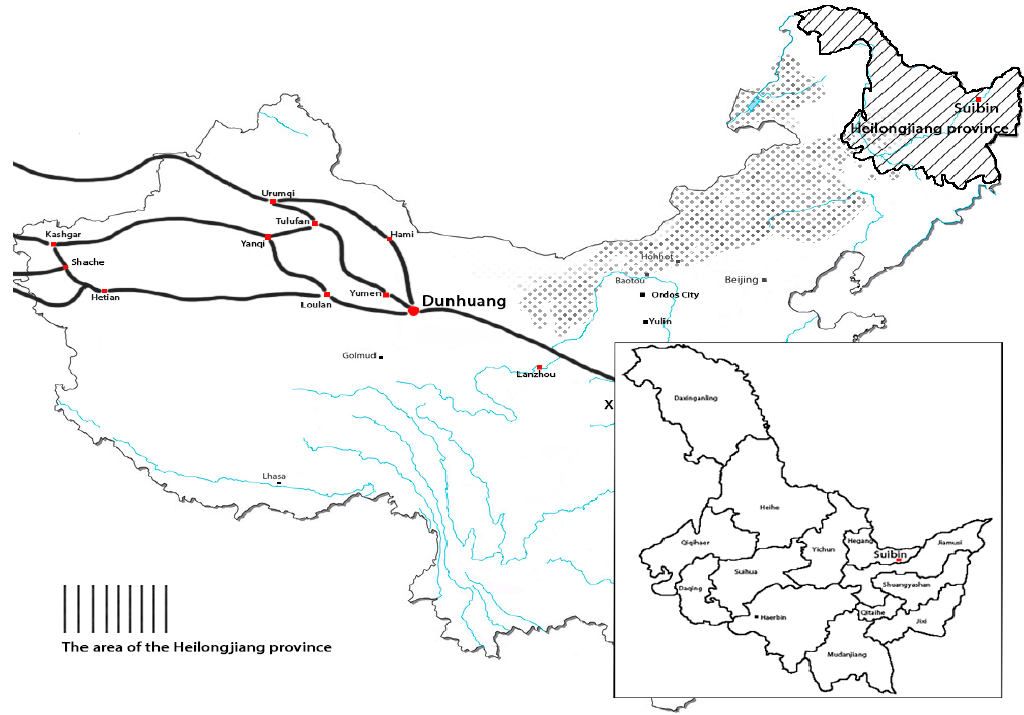
Figure 37. Heilongjiang Province and the Suibin city. Figure 33. The Song Yuan Huaya carved with an ethnic character. The period of the Song and